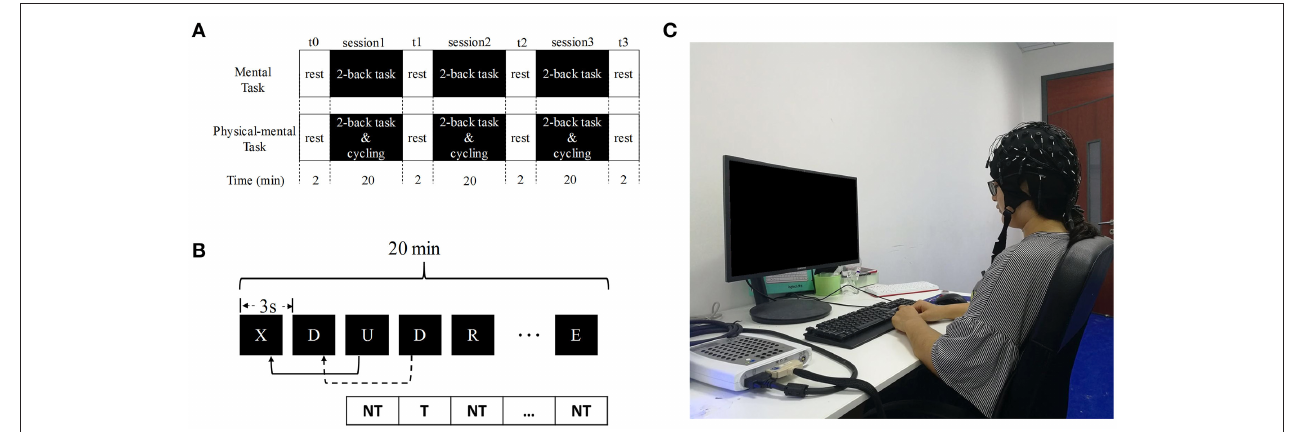
FIGURE 1 | Experimental design. (A) Flowchart of the experiment. (B) An illustration of the two-back task. NT, non-target; T, target. (C) The photo of the one participant during the